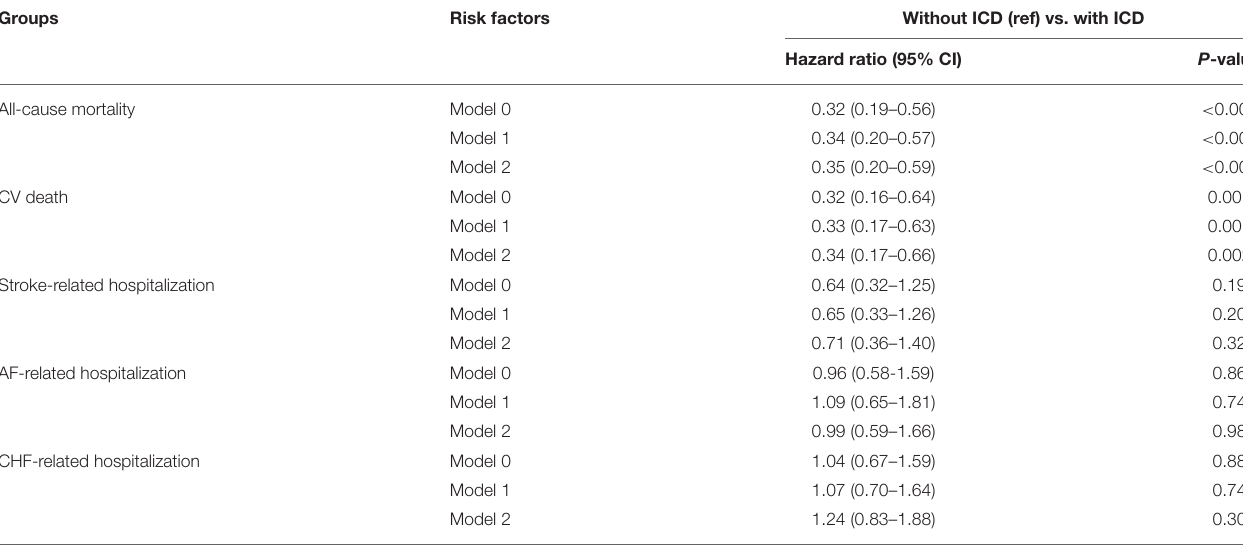
TABLE 6 | Comparison of various outcomes between patients experiencing VTa with and without ICD implantation.